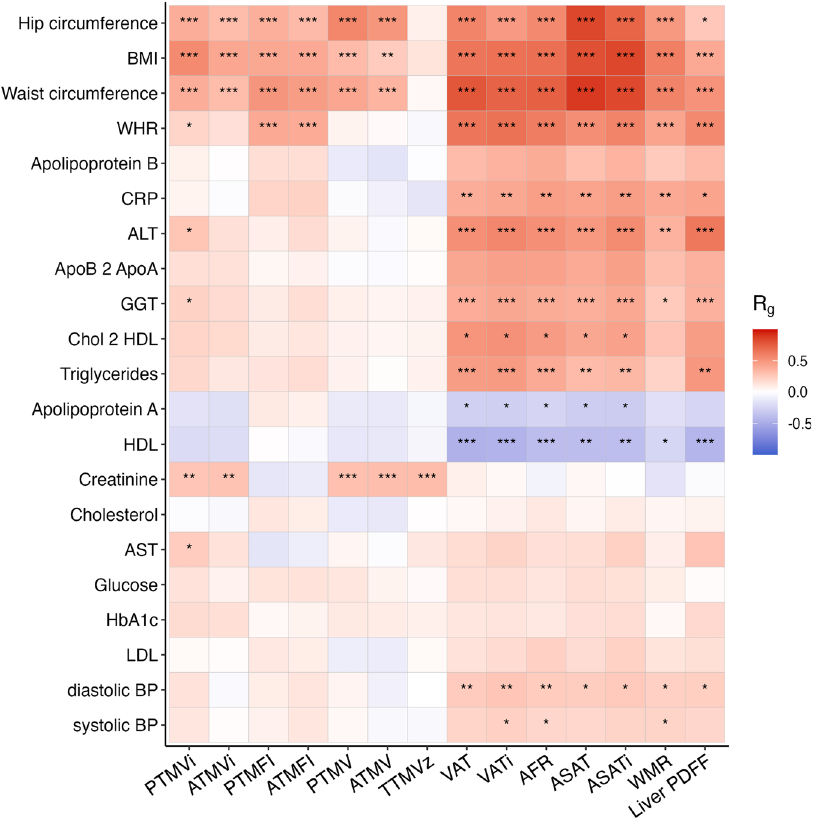
Fig. 4 Genetic correlations of the MRI-derived body composition measures with standard anthropometrics and cardiometabolic measures. Abbreviations: BMI body mass index, WHR waist-hip ratio, CRP C-reactive protein, ALT alanine aminotransferase, GGT gamma-glutamyl transferase, HDL high-density lipoproteins, AST aspartate aminotransferase, HbA1c glycated hemoglobin, LDL low-density lipoproteins, BP blood pressure. *** p = 5 × 10 − 9 , ** p = 5 × 10 − 6 , * p = 5 × 10 − 4